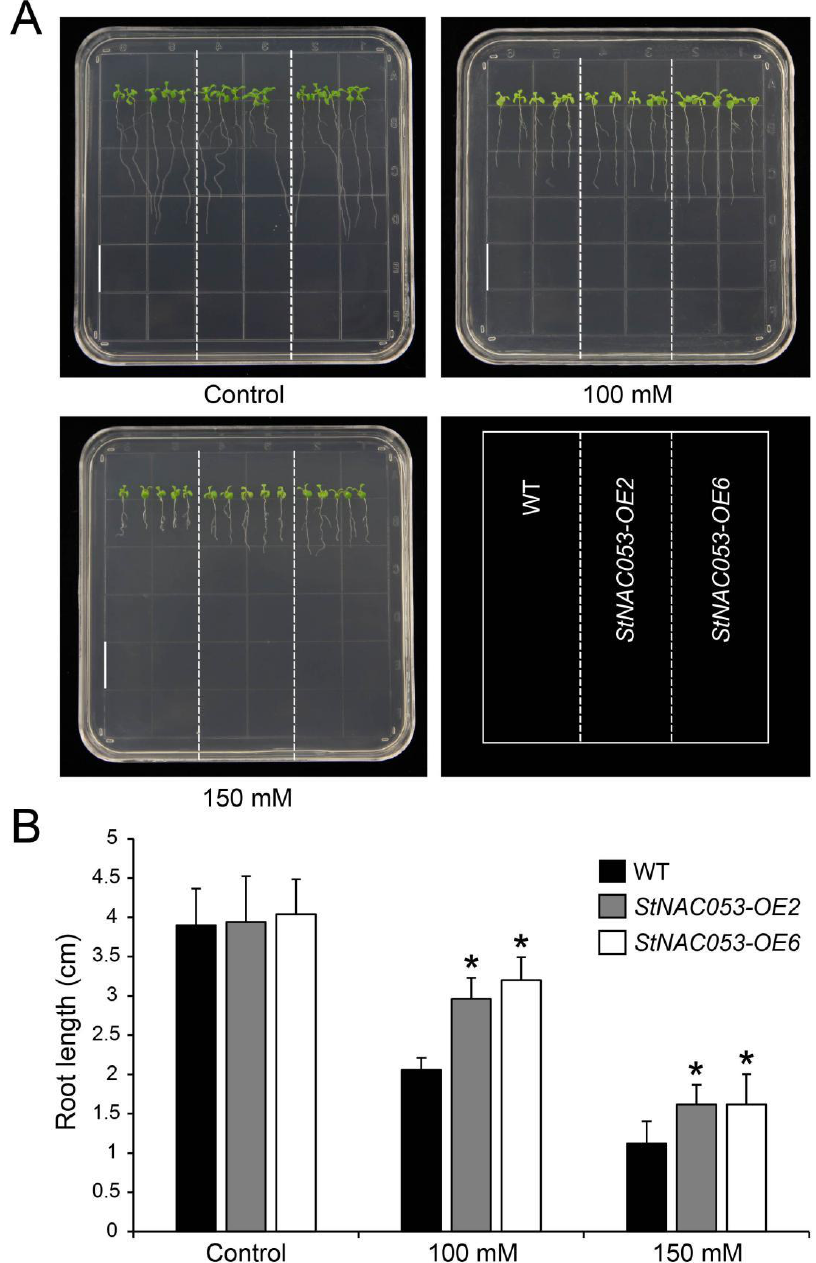
Figure 8. Comparison of root growth between StNAC053 overexpressing and wild-type Arabidopsis under salt stress treatments. ( A ) The primary root length of StNAC053 overexpressing and wild-type Arabidopsis under 100 and 150 mM NaCl treatments. The primary root length were recorded seven days after growth. Bar = 1.5 cm. ( B ) The statistics of primary root length under normal condition, 100 and 150 mM NaCl treatments. WT, wild-type. The data were means ± SD from three independent replications. * p < 0.05 ( t -tests).